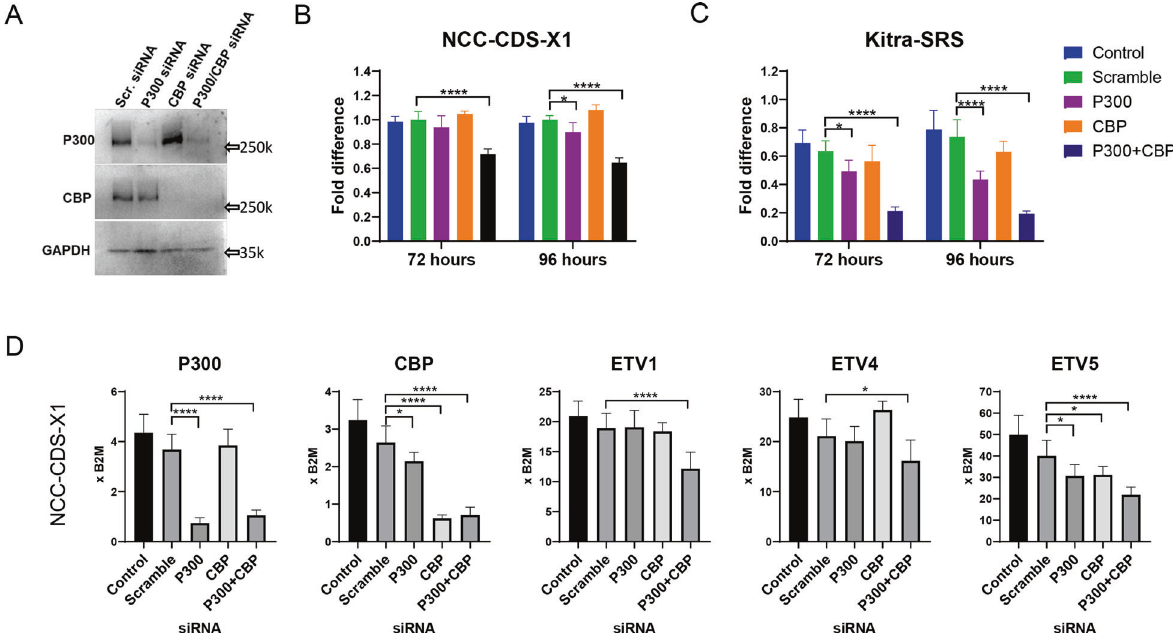
Fig. 1 P300/CBP is required for CIC-DUX4 activity. A Western blots for P300 and CBP in NCC-CDS-X1 cells after 96 h transfection with siRNAs for P300 and CBP. B ATP assay for cell viability of NCC-CDS-X1 at 72 and 96 h of post-transfection with P300 and/or CBP siRNA. Non-treated cells and cells transfected with non-targeting siRNA (scramble) were used as negative controls. Data are presented as mean ± SEM; * p < 0.05, *** p < 0.001 by one-way ANOVA. Results are presented as relative expression to control ( n = 4). C ATP viability assay in the Kitra-SRS cell line in the same experimental conditions as explained in “ B ” . Data are presented as mean ± SEM; **** p < 0.0001, by two-way ANOVA. Results are presented as expression relative to control ( n = 4). D RT-qPCR for P300, CBP, and CIC-DUX4 target genes in NCC-CDS-X1. Analyses were performed 48 h post-transfection with P300 and/or CBP siRNA. Data are presented as mean ± SEM; * p < 0.05, ** p < 0.01, *** p < 0.001 by one- way ANOVA. Results are presented as expression relative to B2M ( n =